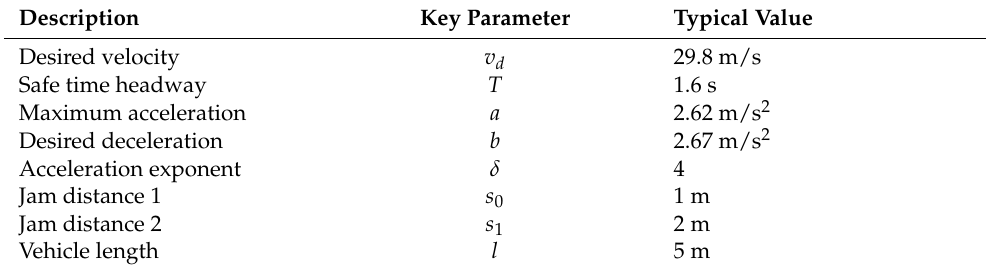
Table 5. Parameter settings for the IDM